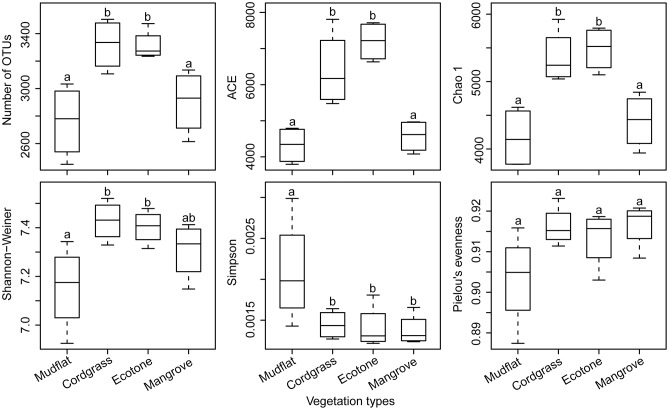
Comparison of alpha-diversity of the soil bacterial communities among four different types of vegetation zones. Ecotone indicates a transition zone with the distributions of cordgrass and mangrove overlap. The operational taxonomic units (OTUs) were defined at 97% sequence similarity threshold. Significant differences (P < 0.05) between vegetation types are indicated by different letters of the alphabet. Statistical analysis is Student's t-test with Bonferroni correction (n = 4). The ends of the box represent the 25th and 75th percentiles, the whiskers represent minimum and maximum range, and the center lines represent the median.